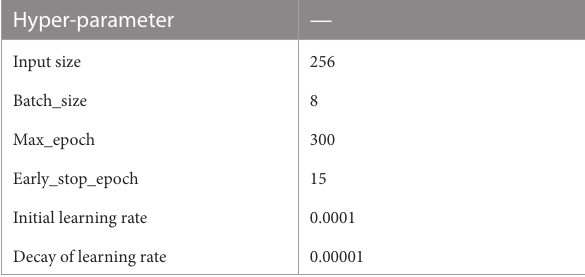
TABLE1 Hyper-parametersettingofthemodel.